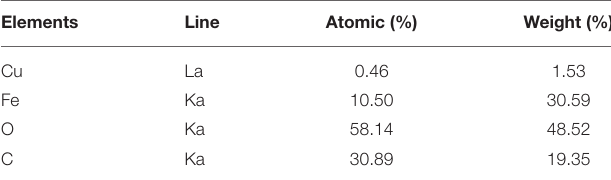
TABLE 2 | Quantitative values of related elements by EDX